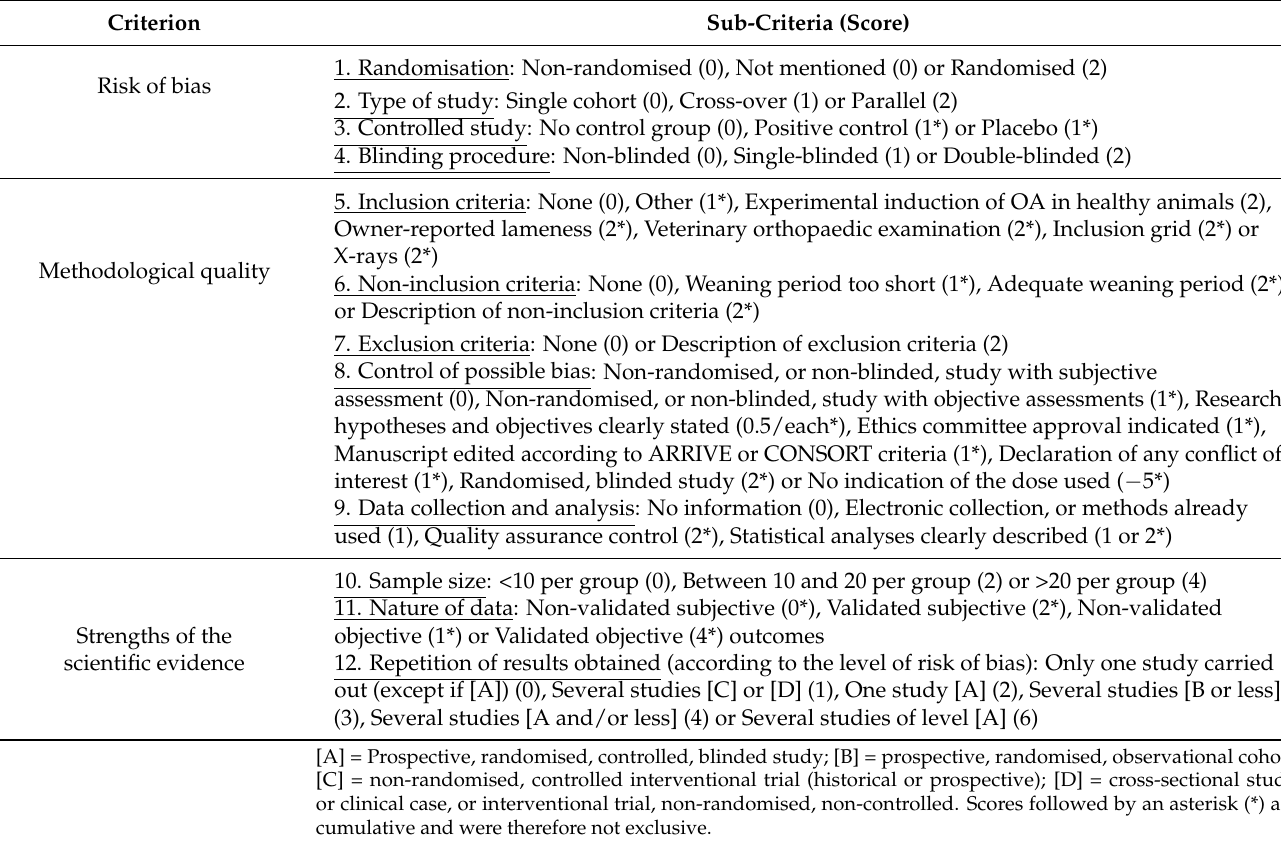
Table 1. Quality assessment